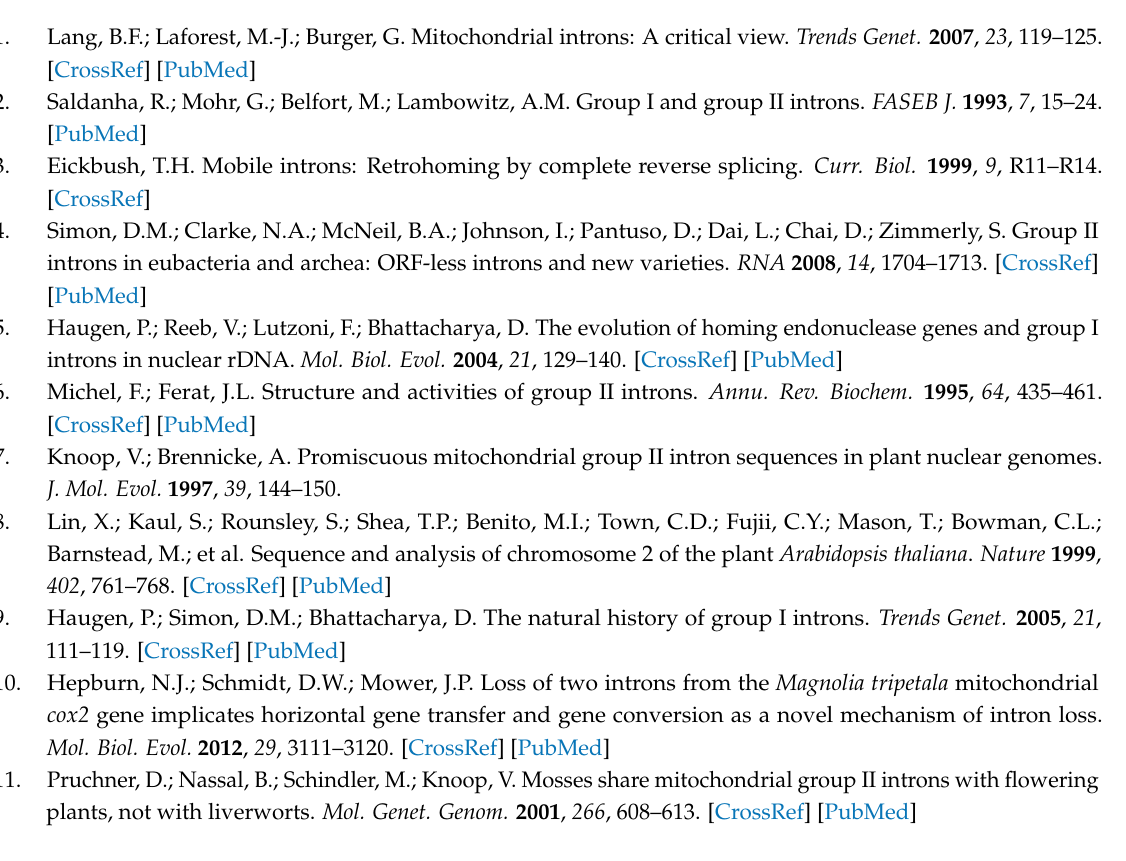
Figure S1: Mauve alignment of six mitogenomes of